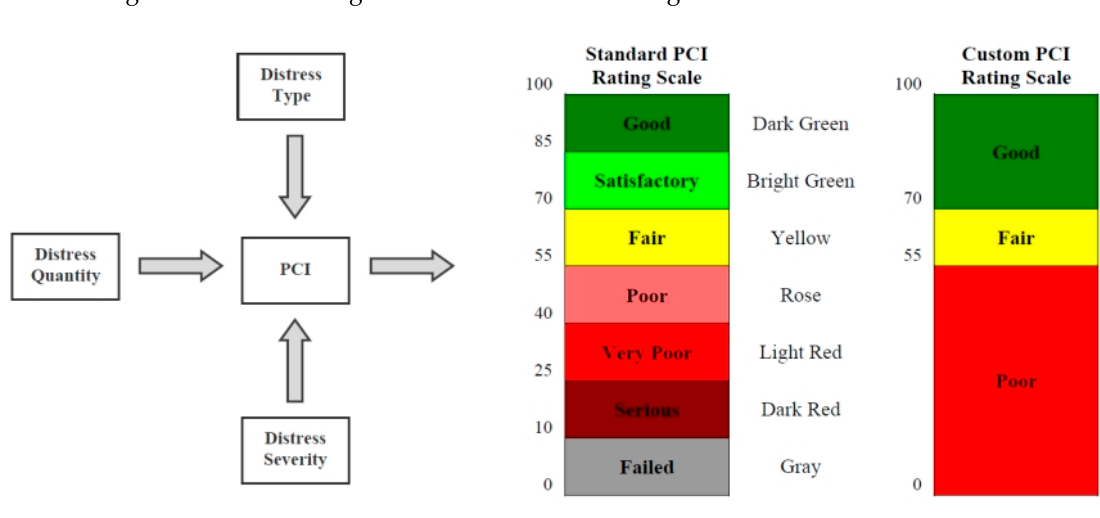
Figure 5. Standard and custom PCI Rating Scale. Source: [28].